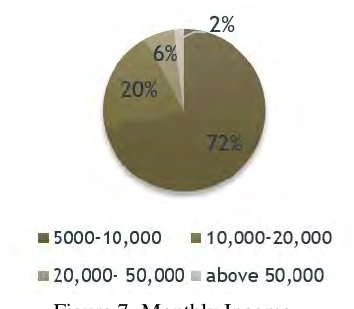
Figure 7. Monthly Income.